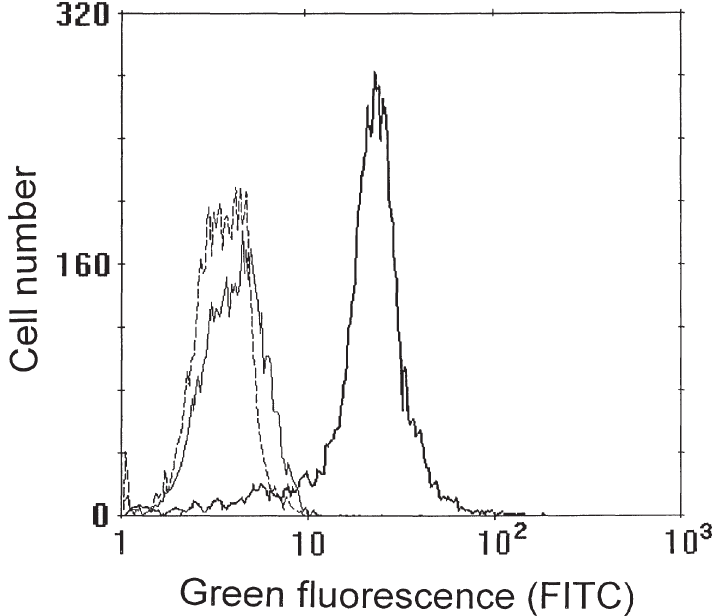
Fig. 1. Flow cytometric Ig class determination of AS-2 antibody. After incubation with primary AS-2, either a secondary specific anti mouse IgG FITC-conjugated antibody (full line) or a specific anti mouse IgM FITC-conjugated antibody (bold line) were used. Negative control was assessed by means of a secondary non-specific FITC-conjugated antibody (broken line). Green fluorescence emission ( x axis) is reported in logarithmic scale, while cell number ( y axis) is in linear scale. Reproducibility of these data was repeatedly